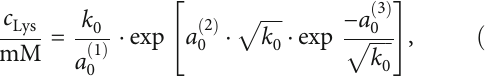
k k Figure 5: Parameters k 0 , F , and S of Equation (2) for correlating the dependence of the lysozyme loading on the ionic strength, cf. Table S.2 in the Supplementary Materials, plotted over the lysozyme concentration c Lys for all studied salts. Symbols: experimental results (correlated with Equation (2)). Lines: correlations with Equation (3), (4), or (5).